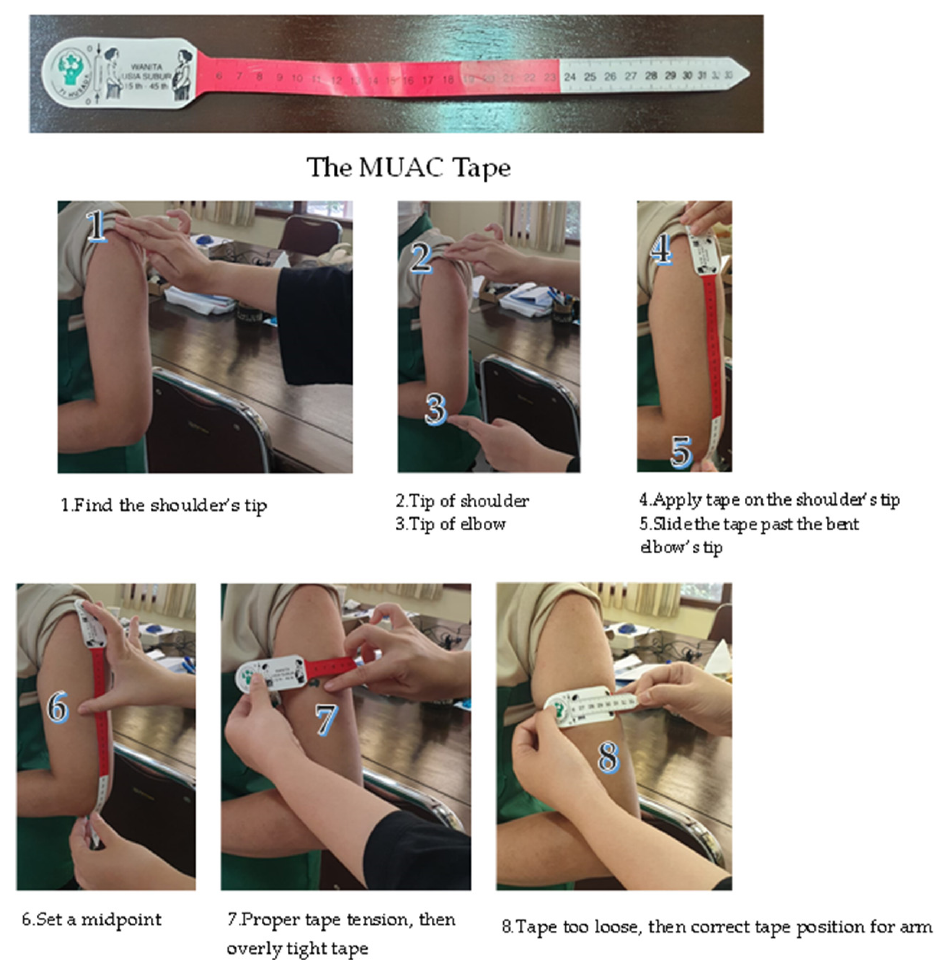
Figure 1. Mid-upper arm circumference (MUAC) Measurement [28].